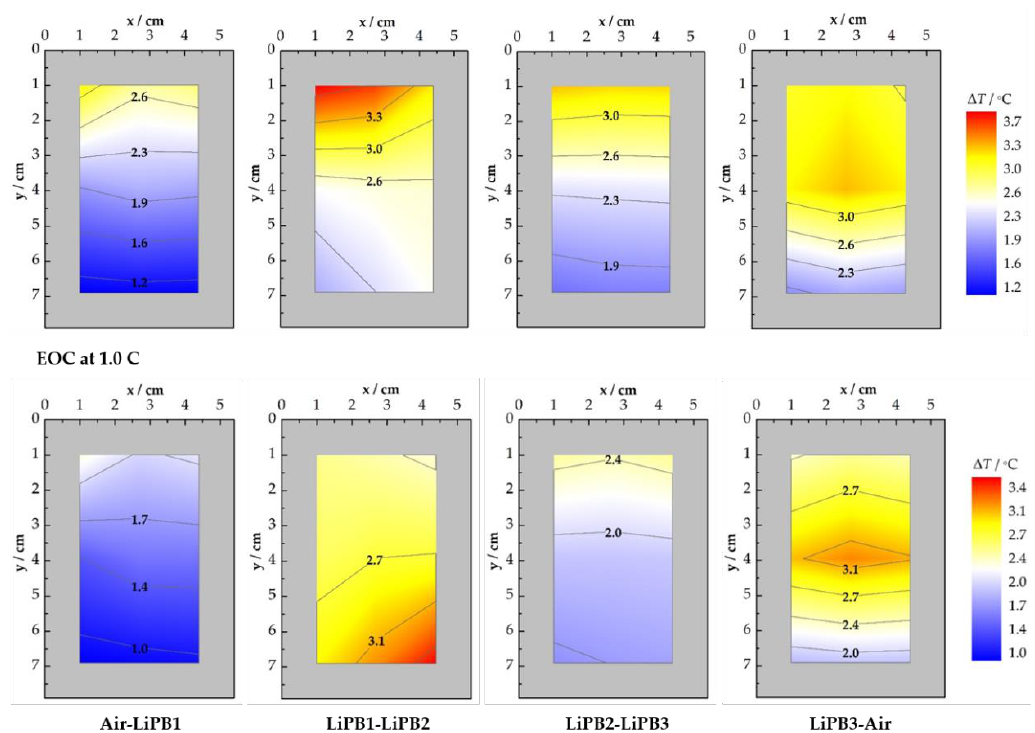
Figure 6. Spatial and temporal thermal mapping of the LiPBs pack when the CC charge at 1.0 C begins and ends.